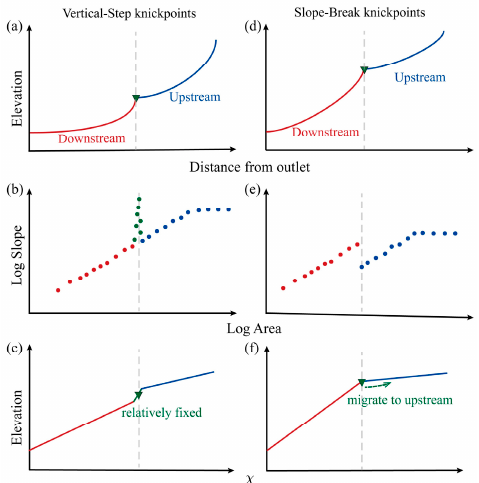
Figure 2. Classification of knickpoints in terms of ( a , d ) the channel profile, ( b , e ) log-log slope-area and ( c , f ) χ -plot, modified from [34]. Assuming both the upstream and downstream channels have reached the stable state, the geomorphic response time of a knickpoint can be estimated by the stream power incision mode. The blue , red lines and green points represent the upstream channel, downstream channel and knickpoints, respectively. The morphologies depict a transient perturbation of the fluvial system or fixed in place by a resistant substrate, landslide debris or active faults.